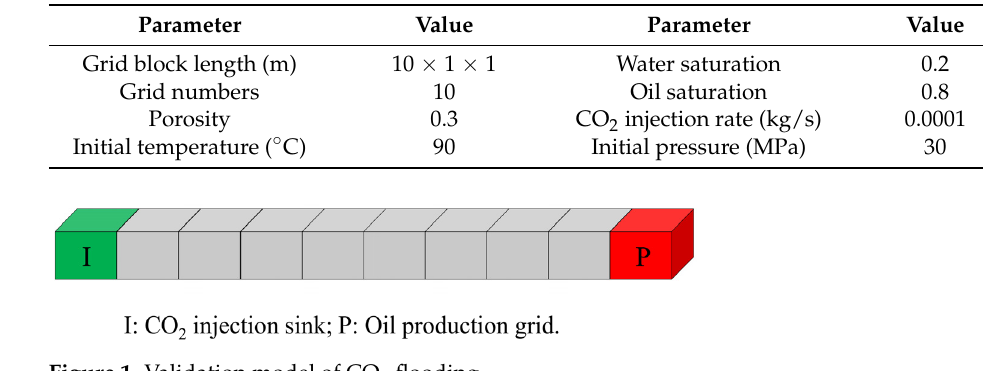
Table 1. Main parameters data of 1D model.